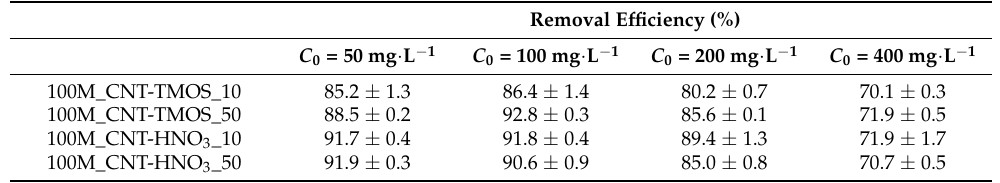
Table 3. Removal efficiency of the carbon nanotubes–silica aerogel composites with two amounts of carbon nanostructure for different initial concentrations of toluene.